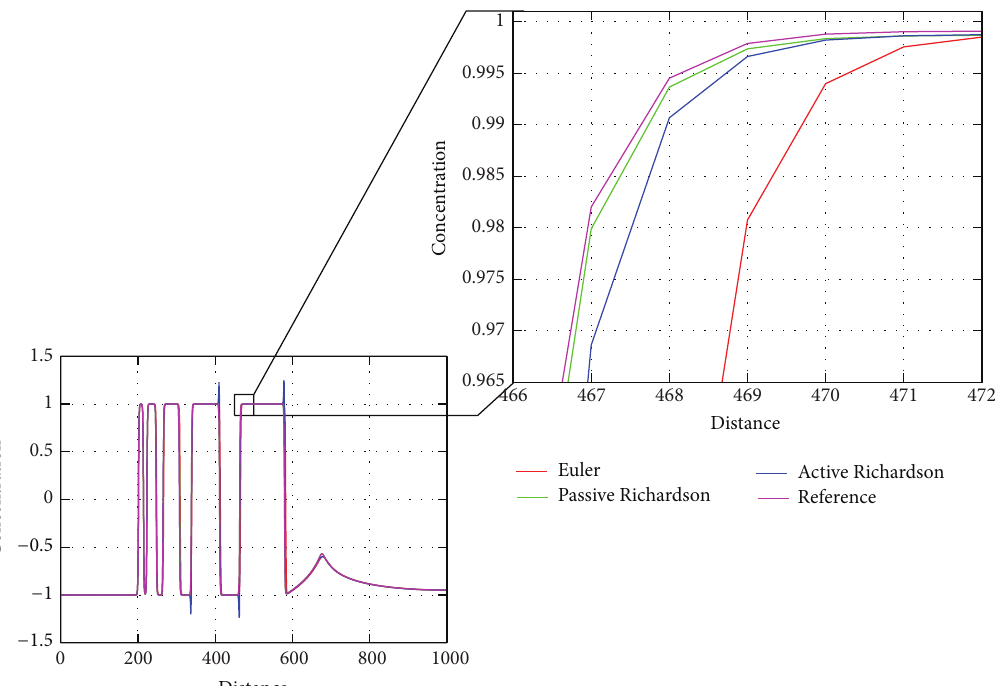
Figure 10: Results of the numerical simulations for the Cahn-Hilliard type reaction-diffusion model obtained by the Euler method without and with passive and active Richardson extrapolations. We used the following parameters in the simulations: Δ𝑥 = 1 , 𝐷 𝐴 = 𝐷 𝐵 = 1.0 , = 10.0 , 𝑏 = 1.0 , and 𝜆 = 𝜖 = 𝛾 = 𝜎 = 1.0 . The reference solution was calculated using Δ𝑡 = 10 −7 𝑎 0 0